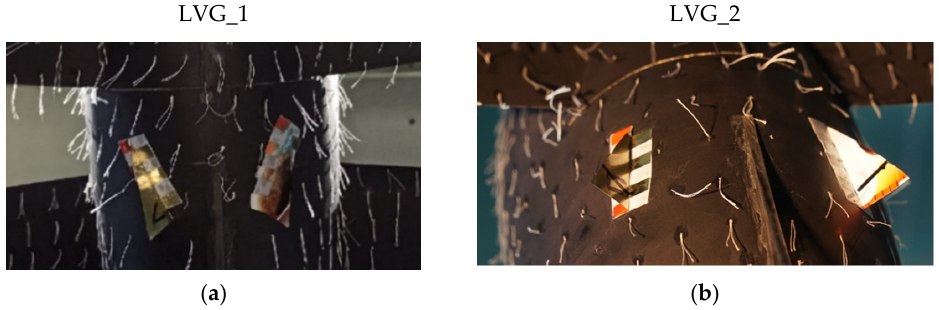
Figure 6. ( a ) Large vortex generators (LVGs) in positions 1 (converging) and 2 (diverging); ( b ) single strake geometry and dimensions.